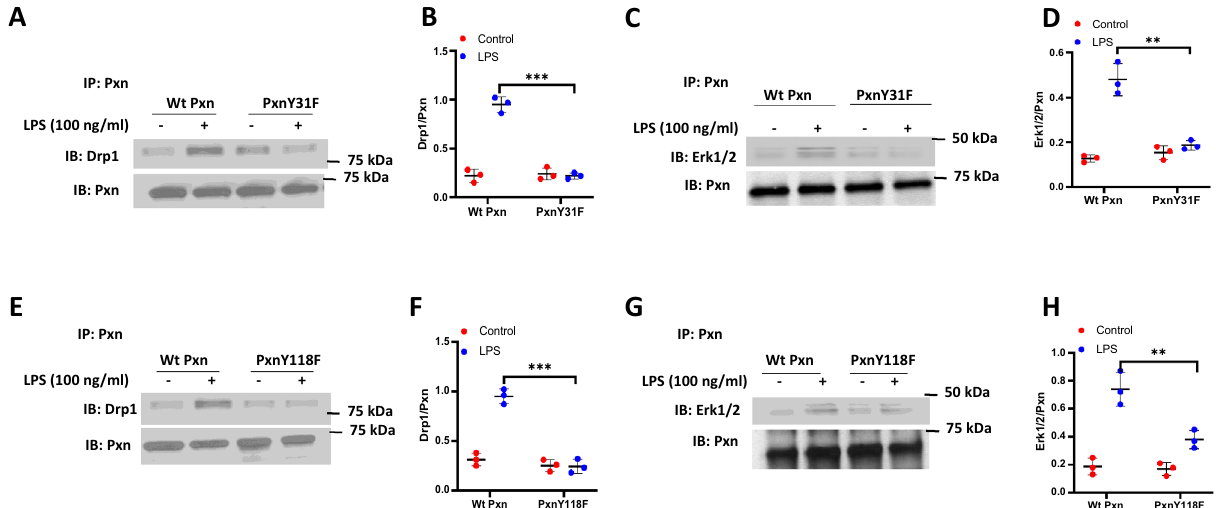
Figure 7. Phosphorylation of paxillin Y31 and Y118 is required for paxillin interactions with Erk1/2 and DRP1. ( A – D ) HLMVECs were transfected with wild type paxillin or paxillinY31F mutant plasmids, interactions of paxillin with DRP1 and Erk1/2 was assessed by IP experiment. Data were presented as means ± SD, **p < 0.01, LPS wild type paxillin versus LPS paxillinY31F mutant; ***p < 0.005, LPS wild type paxillin versus LPS paxillinY31F mutant, n = 3. E–H, HLMVECs were transfected with wild type paxillin or paxillinY118F mutant plasmids, interactions of paxillin with DRP1 and Erk1/2 was assessed by IP experiment. Data were presented as means ± SD, **p < 0.01, LPS wild type paxillin versus LPS paxillinY118F mutant; ***p < 0.005, LPS wild type paxillin versus LPS paxillinY181F mutant, n = 3.